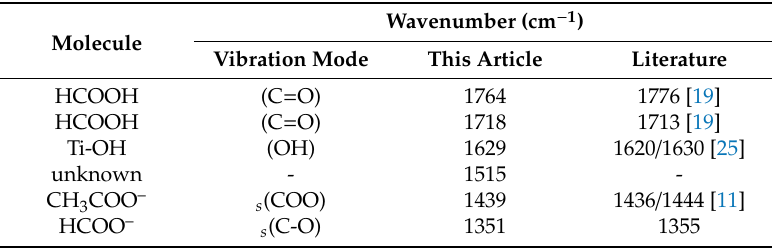
Table 8. Assignment of FTIR bands observed for commercial rutile-type titania samples after photocatalytic decomposition of